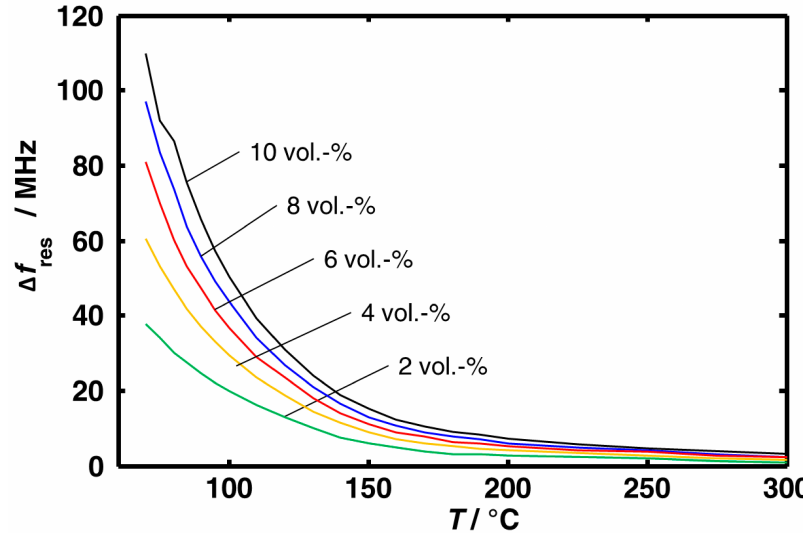
Figure 5. Resonance frequency differences, ∆ f res , between water free and 2–10 vol. % water containing feed gas, measured with a fresh catalyst